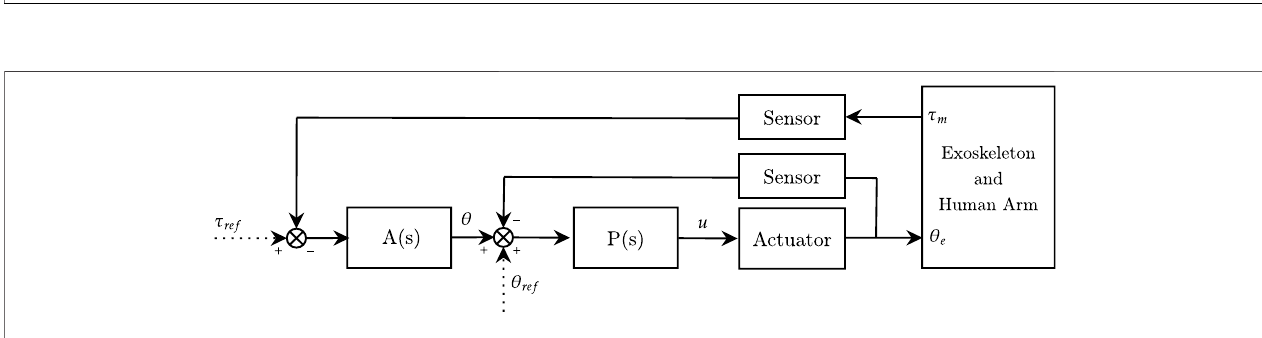
FIGURE 6 | Admittance control scheme in the joint-space. A ( s ) is the admittance controller, P ( s ) is the position controller. θ ref and τ ref represent respectively reference angular position and torque, while u refers to the motor current control signal.